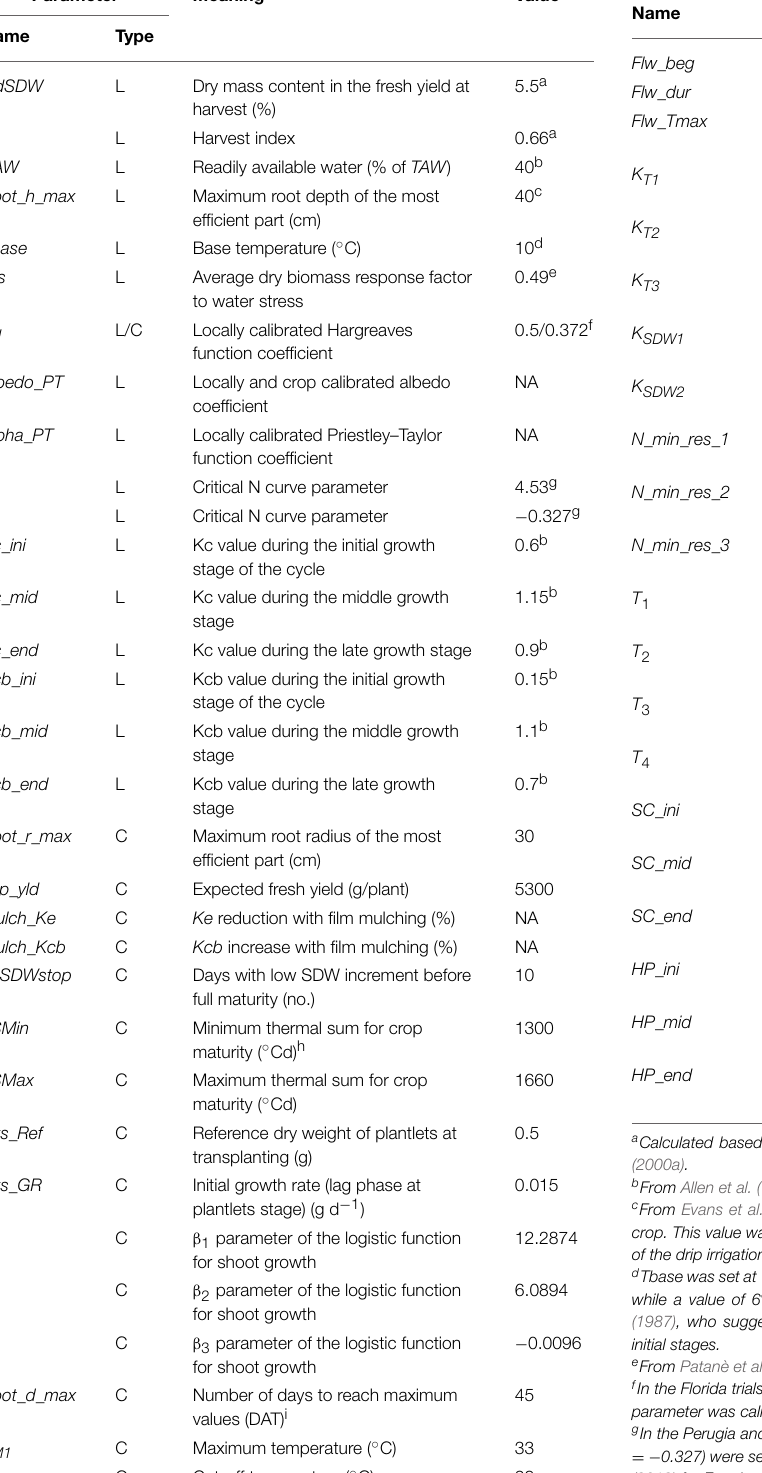
TABLE 2 | Parameters for setting GesCoN to work on field grown tomato taken from the literature (L) or calibrated (C). Parameter